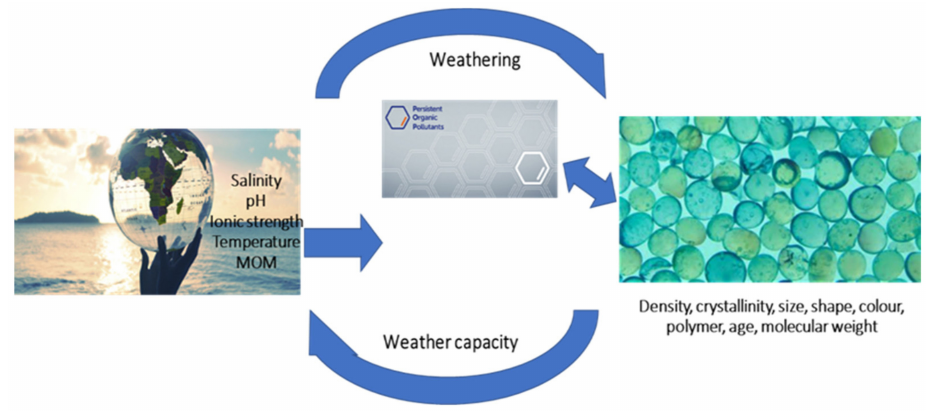
Figure 3. Factor governing the interaction between MPs and